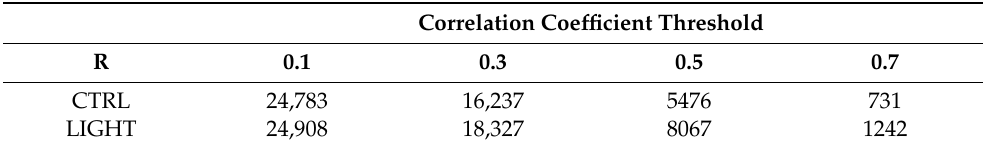
Table 1. Number of grid points out of a total of 27,602 grid points where the CTRL or LIGHT correlation coefficient is greater than a selected threshold.